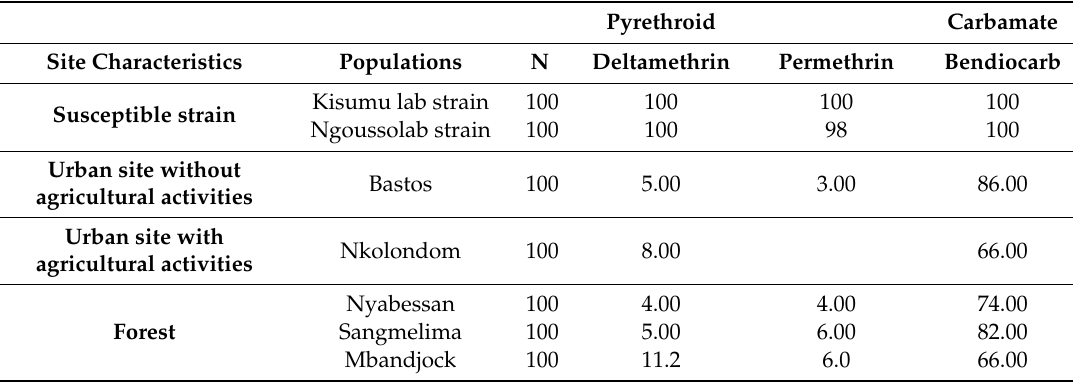
Table 1. Mortality rate of field collected and laboratory strains Anophelesgambiae s.l. exposed